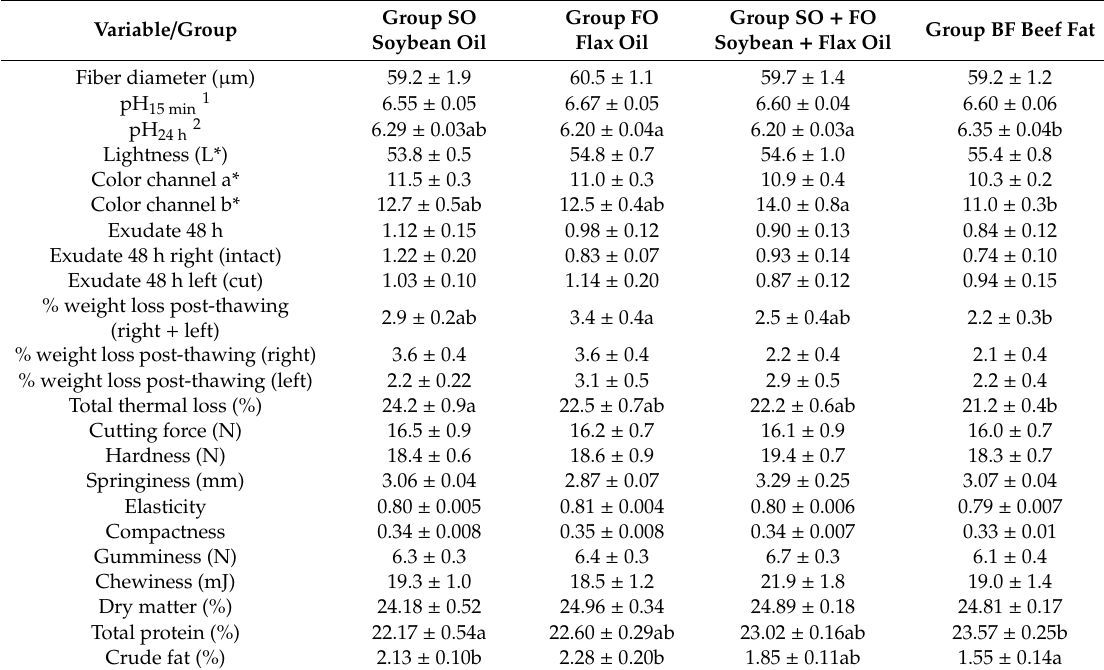
Table 1. The mean ( ± SEM) fiber diameters and physicochemical properties of pectoralis major muscles in broiler chickens allocated to four fat-supplementation groups (each n = 10): Within the rows, mean values denoted by di ff erent letters are significantly di ff erent ( p <